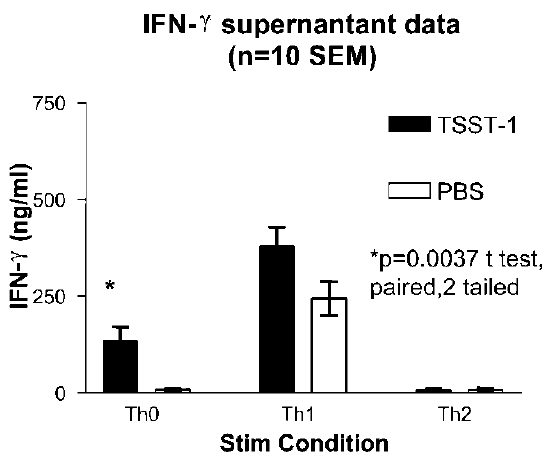
FIG. 3. Absolute IFN- g production by T h cells isolated from repeatedly invivoPBS or TSST-1 treated mice as detected by ELISA (detection limit, 7.5 pg/ml) under different in vitro polarising conditions, including T h 0, T h 1 and T h 2 conditions.